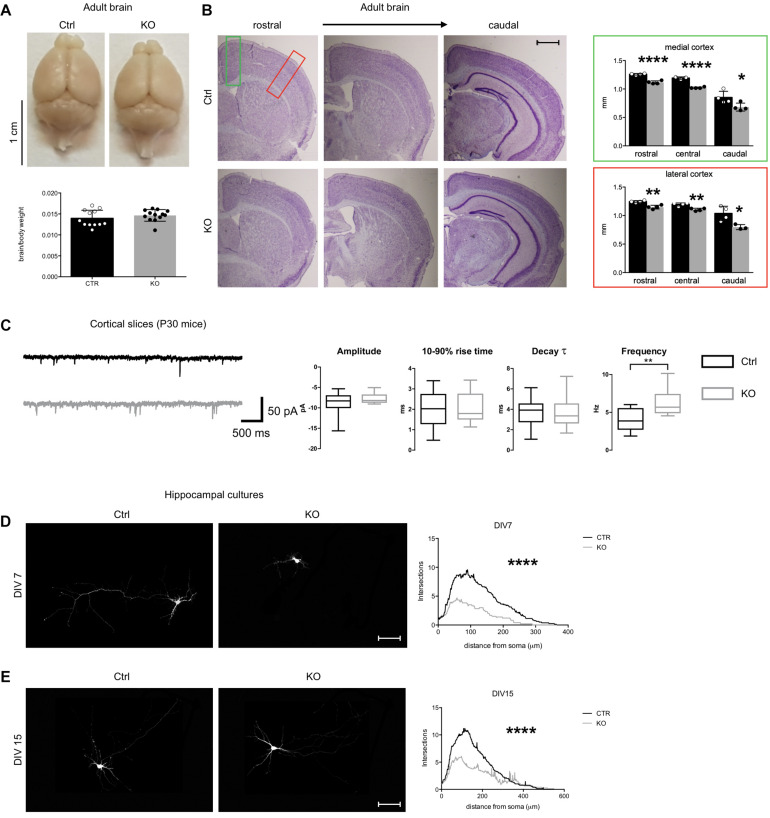
Defects of Tbl1xr1 mutant neurons. (A) Adult brains from both control and Tbl1xr1 mutant mice showed similar brain to body ratio (shown as means ± SEMs, with dots representing individual samples), n: Ctrl = 12, KO = 13: p > 0.05, unpaired t-test. (B) Left, cresyl violet staining of coronal section of both control and mutant forebrains (cerebral corte, striatum, and hippocampus from adult mice of >than 2 months of age). right quantification of the cortical thickness in medial (green square) and lateral (red) position (shown as means ± SEMs, with dots representing individual samples), n: Ctrl = 4, KO = 4: rostral: ****p < 0.0001; central: ****p < 0.0001; rostral: *p < 0.0415. (C) Left, representative traces showing sEPSCs recorded in cortical pyramidal neurons in slices from control (black) and Tbl1xr1 mutant (gray) mice (animals of both sexes, 30 days of age) (bars: 50 pA, 500 ms). Right, summary boxplots for EPSC parameters (shown as box for interquartile range, median line and whiskers for highest and lowest values): mean amplitude, wt -8.6 ± 0.6 pA, KO -7.8 ± 0.3 pA, n = 19, p = 0.27, unpaired t-test; mean 10–90% rise time, wt 1.9 ± 0.2 ms, KO 2.0 ± 0.2 ms, n = 19, p = 0.78, unpaired t-test; mean decay time constant, wt 3.7 ± 0.3 ms, KO 3.6 ± 0.4 pA, n = 19, p = 0.87, unpaired t-test; mean frequency, wt 4.0 ± 0.3 Hz, KO 6.3 ± 0.4 Hz, n = 19, p < 0.001, unpaired t-test. (D) Hippocampal cultures from control and mutant E17.5 embryos at 7 days in vitro (DIV) infected with low titer GFP lentivirus (at DIV0) and Sholl analysis for the quantification of the intersection of neurites accordingly with the distance to the soma, ****p < 0.0001, 2-way ANOVA. (E) Hippocampal cultures from control and mutant E17.5 embryos at 14 days in vitro (DIV) infected with low titer GFP lentivirus (at DIV0) and Sholl analysis for the quantification of the intersection of neurites accordingly with the distance to the soma, ****p < 0.0001, 2-way ANOVA. Scale bars: (B) 400 μm; (D,E) 50 μm. See also Supplementary Figure S2.